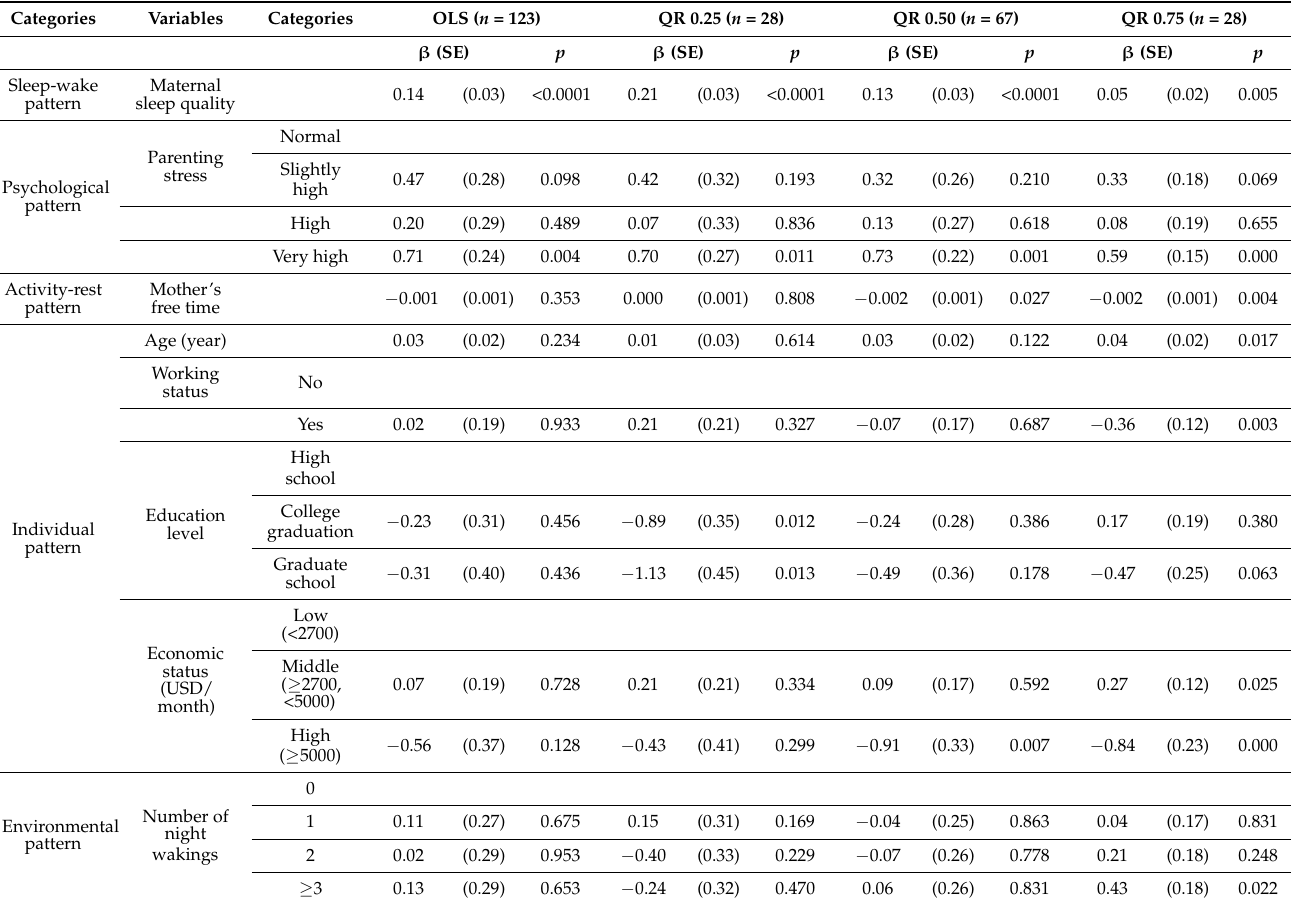
Table 2. The Results of Quantile Regression of Factors Associated with Maternal Fatigue ( n =